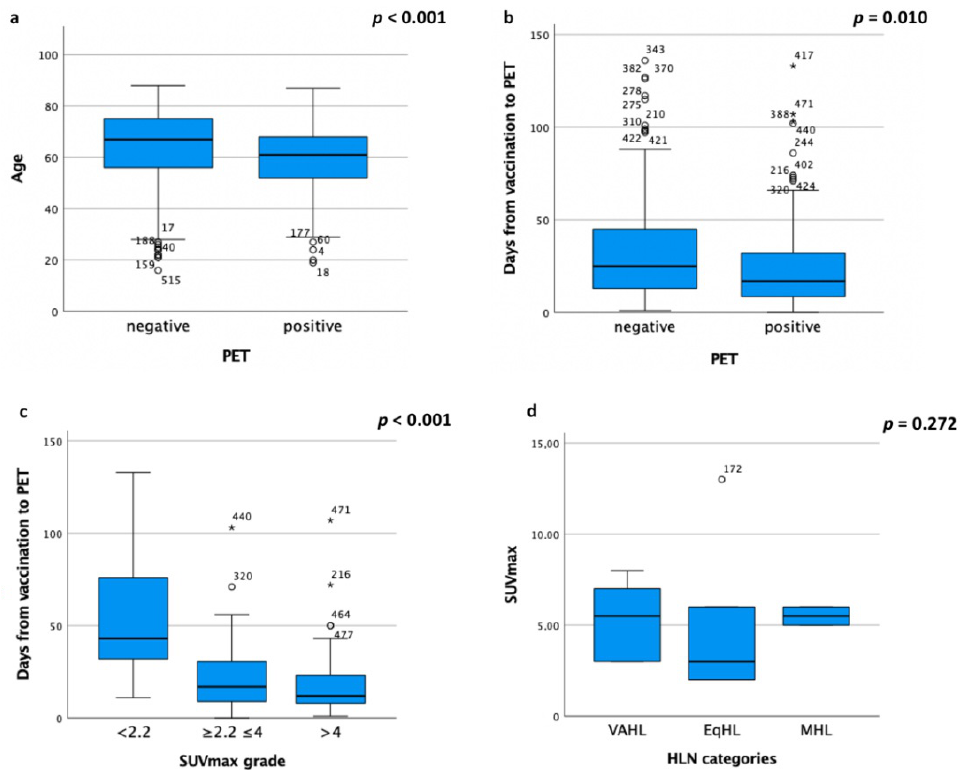
Figure 3. Box plots of ( a ) age and ( b ) days from vaccine-to-PET in PET findings, ( c ) days from vaccine-to-PET in SUVmax grade groups and ( d ) SUVmax value in HLN risk classes. ° Outlier outside the Upper Inner Fence; * Outlier outside the Upper Outer Fence. SUVmax: maximum standardized uptake value; HLN: hypermetabolic lymphadenopathy.